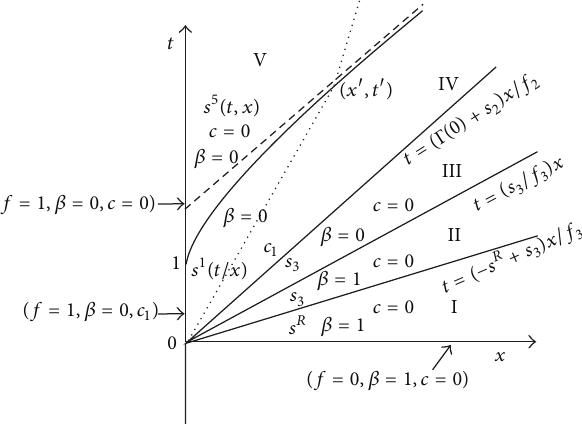
Figure 14: Non-self-similar solution of the problem for wave interactions in (𝑥,𝑡) -plane when 𝑐 2 = 0